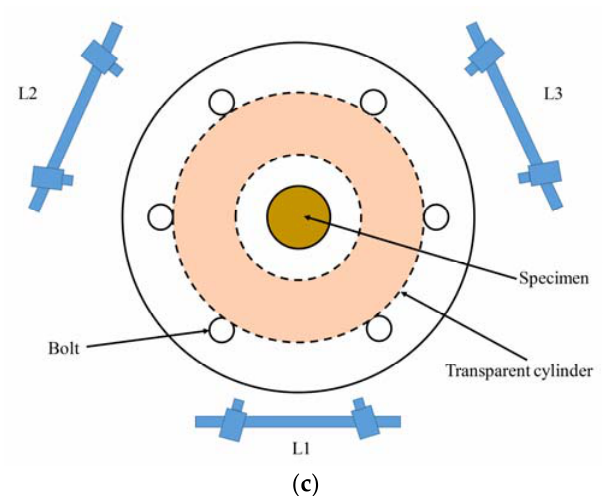
Figure 1. The setup of the loading system and DIC system: ( a ) schematic; ( b ) overview; ( c ) arrangement of the six cameras.